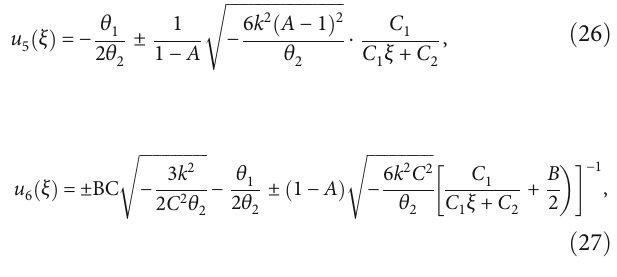
Figure 2: The solution u parameter.